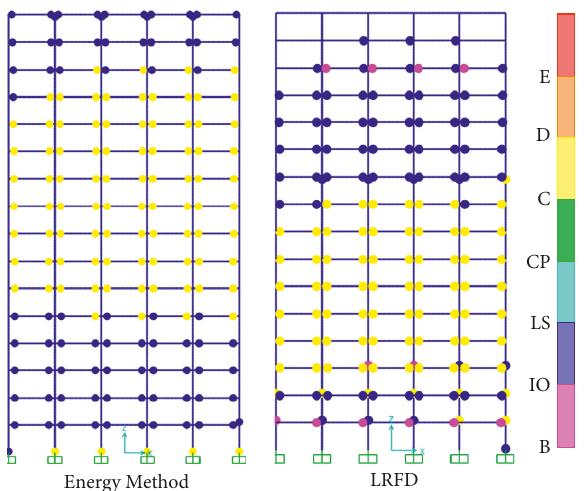
Figure 16: Plastic hinges created in the 16-story frames designed by the energy and LRFD